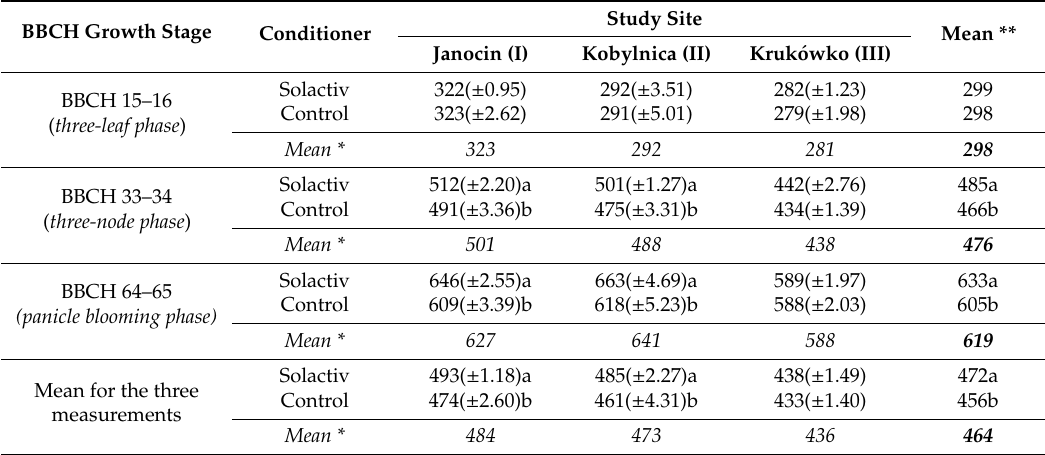
Table 4. The leaf greenness index (SPAD) at the three study sites as a ff ected by the applied conditioner (mean ± SE).